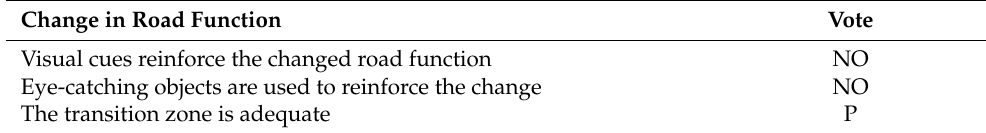
Table 11. Evaluations of the “Change in road function” investigation topic. Change in Road Function